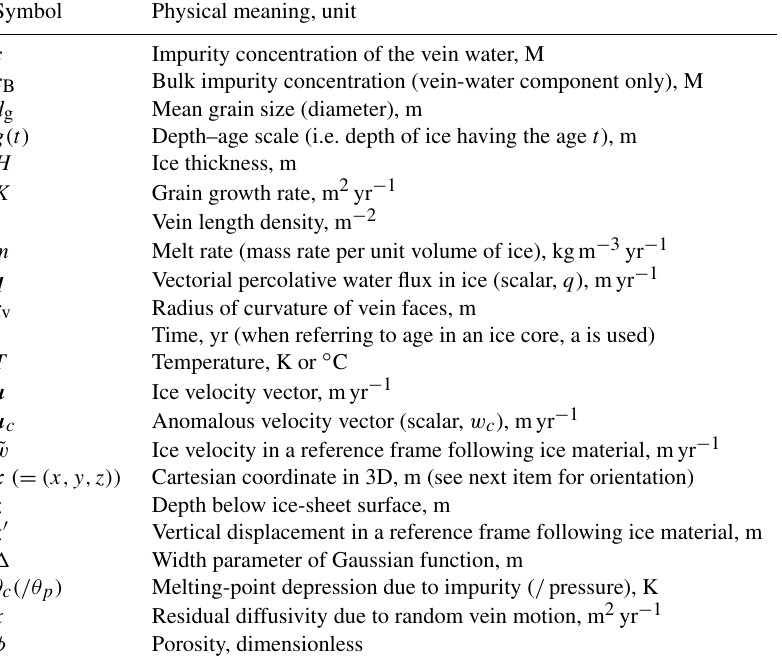
Table 2. Variables in our mathematical model and their